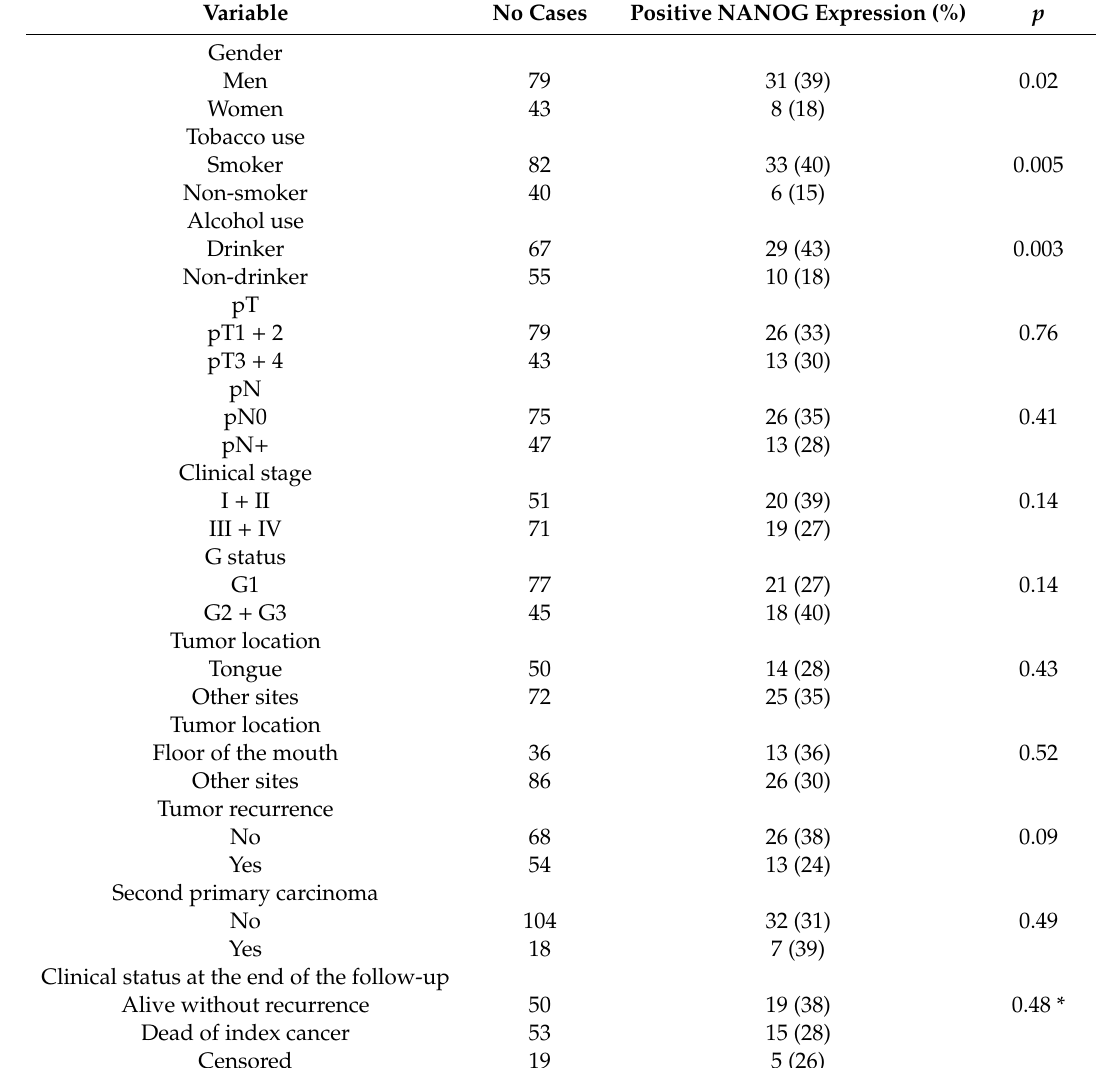
Table 5. The relationship between clinicopathological variables and NANOG expression in the cohort of 125 OSCC